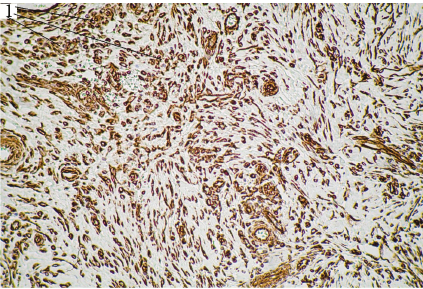
Figure 9: Experimental gastrointestinal stromal tumour (GIST), IHC reaction with antibodies against CD117 receptors, magni fi cation 200x (1: tumour elements from cells of